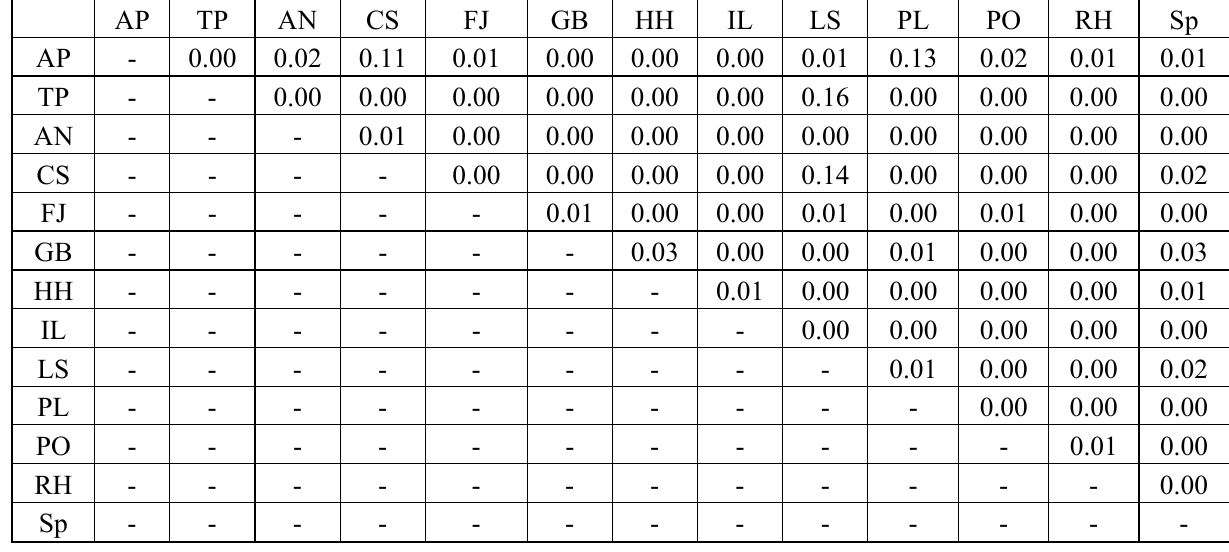
Table 4. The results of t-test ( p -values) between Jeffries Matusita (J-M) distances, calculated from genetic algorithms and randomly selected